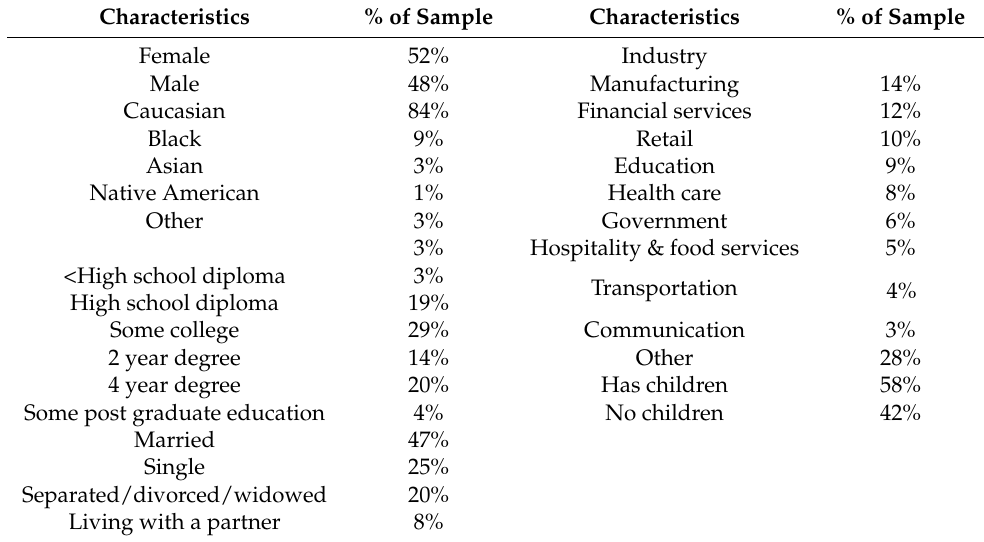
Table 1. Demographics of the